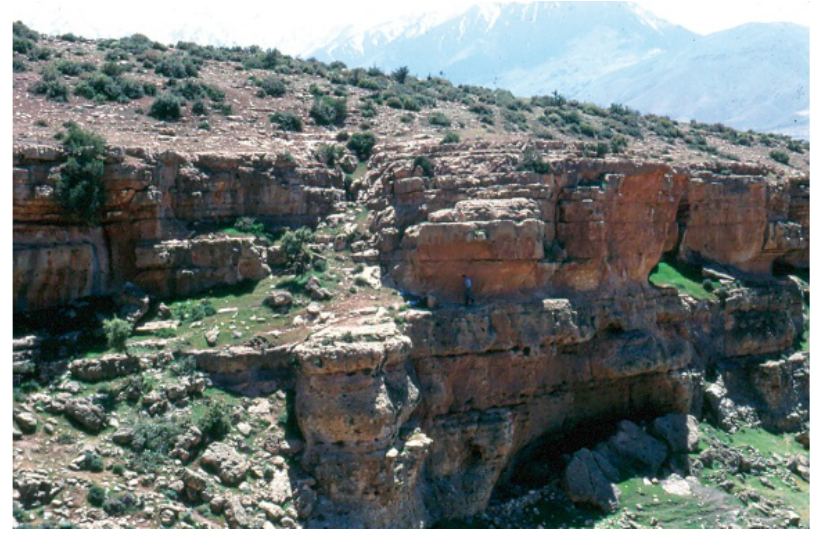
Figure 5. Images from Tidrit (drawing Searight)